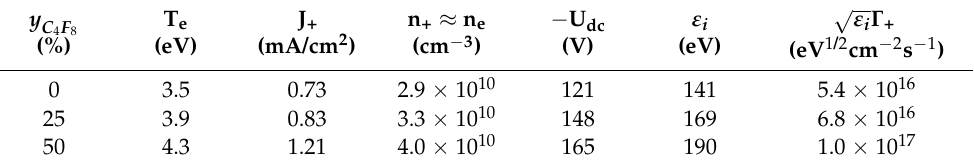
Table 2. Electron- and ion-related plasma parameters in CF 4 + C 4 F 8 + Ar plasma at p = 4 mTorr, W = 800 W, W dc = 150 W and y Ar =